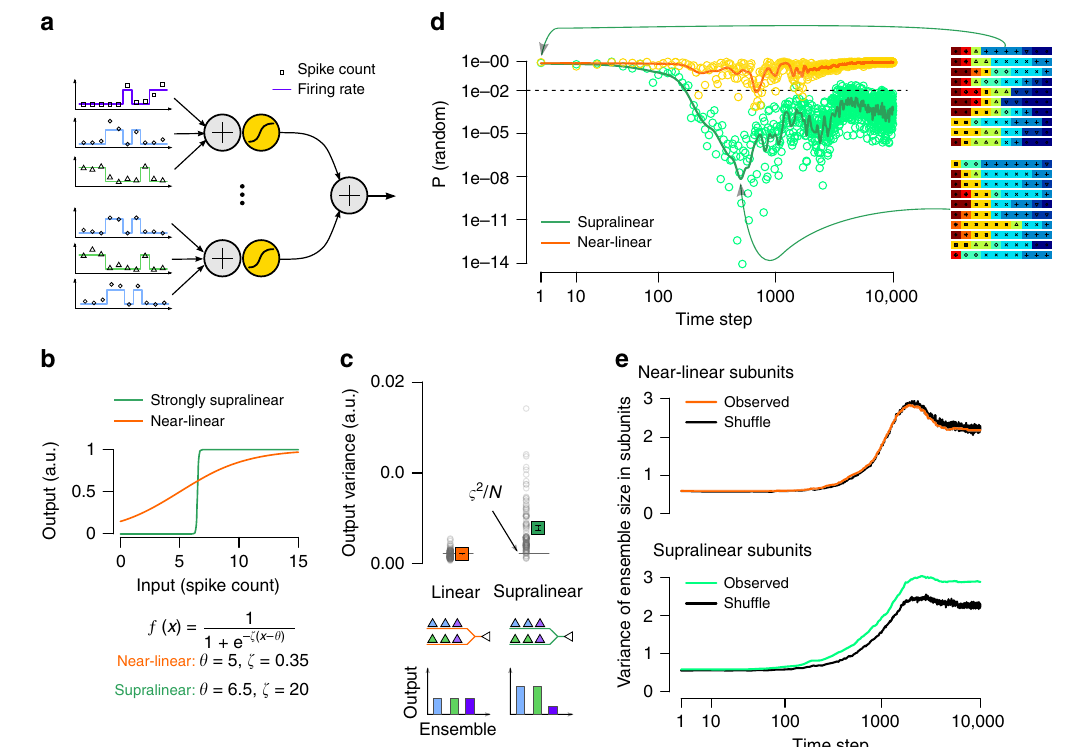
Fig. 1 Global plasticity can lead to functional clustering. a Input integration in a simpli fi ed neuron model. Left: Presynaptic inputs ( N = 100, only 6 shown) divided into 10 discrete ensembles (colours; 3 shown). The fi ring rate (lines) of the ensembles switched between a low and a high activity state, and the activation of a particular ensemble corresponded to a speci fi c spatial location. Spike counts (symbols) were sampled from a Poisson distribution in 100 ms bins, corresponding to theta cycles. Right: Each of the 10 dendritic subunits (2 shown) fi rst integrated the incoming spike counts ( + sign) and then applied a pointwise nonlinearity (yellow sigmoidal function) modelling dendritic spikes. The output of the neuron was the sum of the inputs from all branches. b By changing the parameters of the sigmoid subunit nonlinearity we could interpolate between near-linear (orange) and strongly supralinear (green) integration. c Variance of the postsynaptic tuning curve (mean response to the activation of the 10 ensembles) with near linear and supralinear subunits. Symbols show mean and SEM of N = 100 input connectivity, horizontal line indicates the variance expected from trial-to-trial variability, ς 2 ∕ N (Methods). Bottom: schematics illustrating the connectivity of the inputs and the output of the cell when the same number of inputs is selected from each ensemble (uniform input condition, Methods) with 2 subunits and 3 ensembles. d The probability that the observed connectivity pattern is consistent with random innervation with linear (yellow) and supralinear (green) subunits. The connectivity becomes signi fi cantly non-random after ≈ 200 time steps in the case of supralinear subunits (green). Note the logarithmic x and y axis. Green and orange lines indicate moving average. Insets show the identity of the presynaptic ensembles (colours and symbols) targeting the 10 dendritic subunits (horizontal rows) in one typical neuron at the beginning of the simulations (top) and at the most clustered stage (bottom). e Variance of the cluster size was larger than in the shuf fl ed control in the model with supraliner subunits, indicating the presence of functional